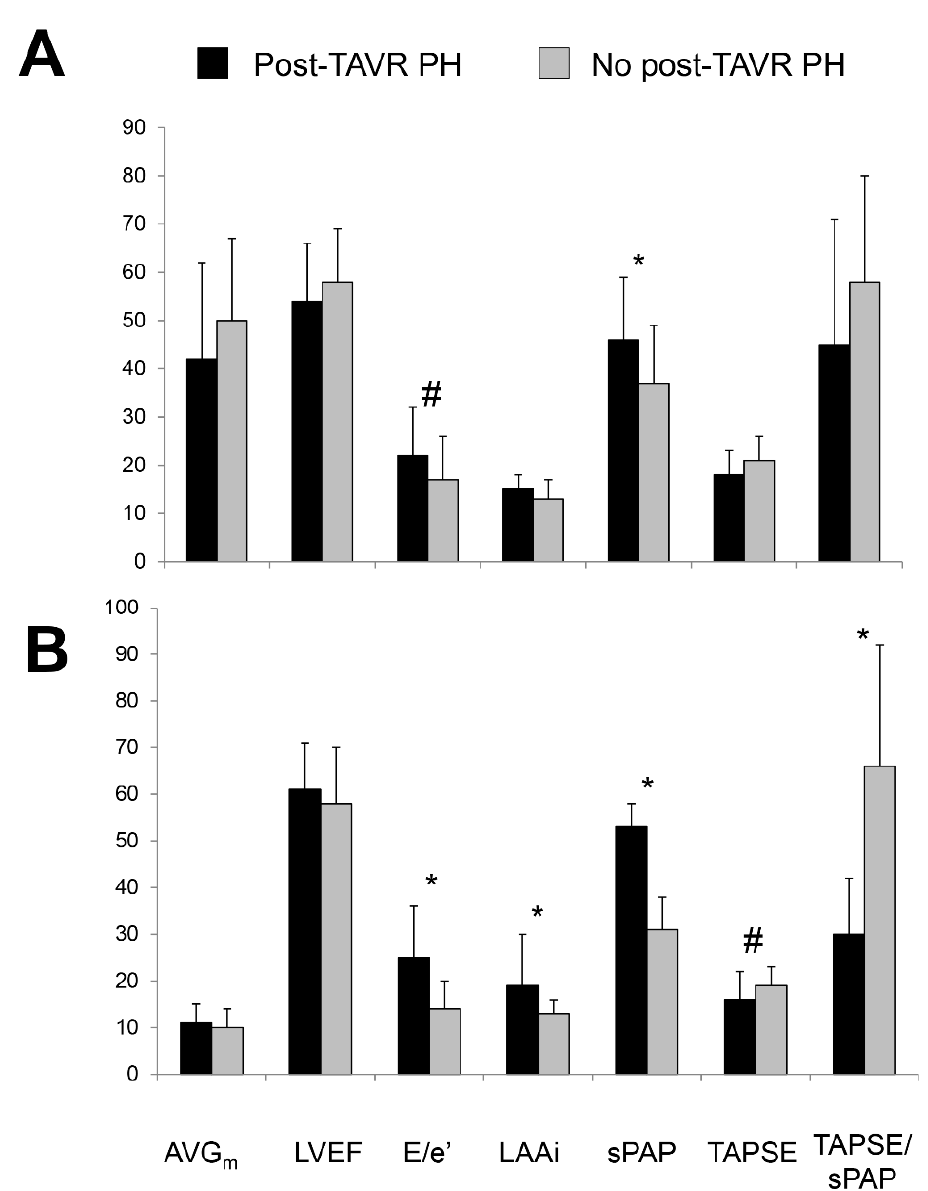
Figure 2. Key echocardiographic parameters prior to aortic valve replacement (panel ( A )) and several months after aortic valve replacement (panel ( B )) in patients with and without pulmonary hypertension several months after aortic valve replacement (post-AVR PH, defined as systolic pulmonary artery pressure > 45 mmHg by echocardiography). Bar graphs represent means ± standard deviations. * p < 0.01, # p < 0.05. AVG m = mean aortic valve gradient, E/e’ = ratio of peak early mitral inflow velocity to peak early mitral annular velocity, LAAi = indexed left atrial area, LVEF = left ventricular ejection fraction, sPAP = systolic pulmonary artery pressure, TAPSE = tricuspid annular plane systolic excursion, TPASE/sPAP = ratio of TAPSE to sPAP as a noninvasive measure of right ventricular to pulmonary artery coupling. The scale is mmHg, %, dimensionless, cm 2 /m 2 , mmHg, mm, mm/mmHg × 100.